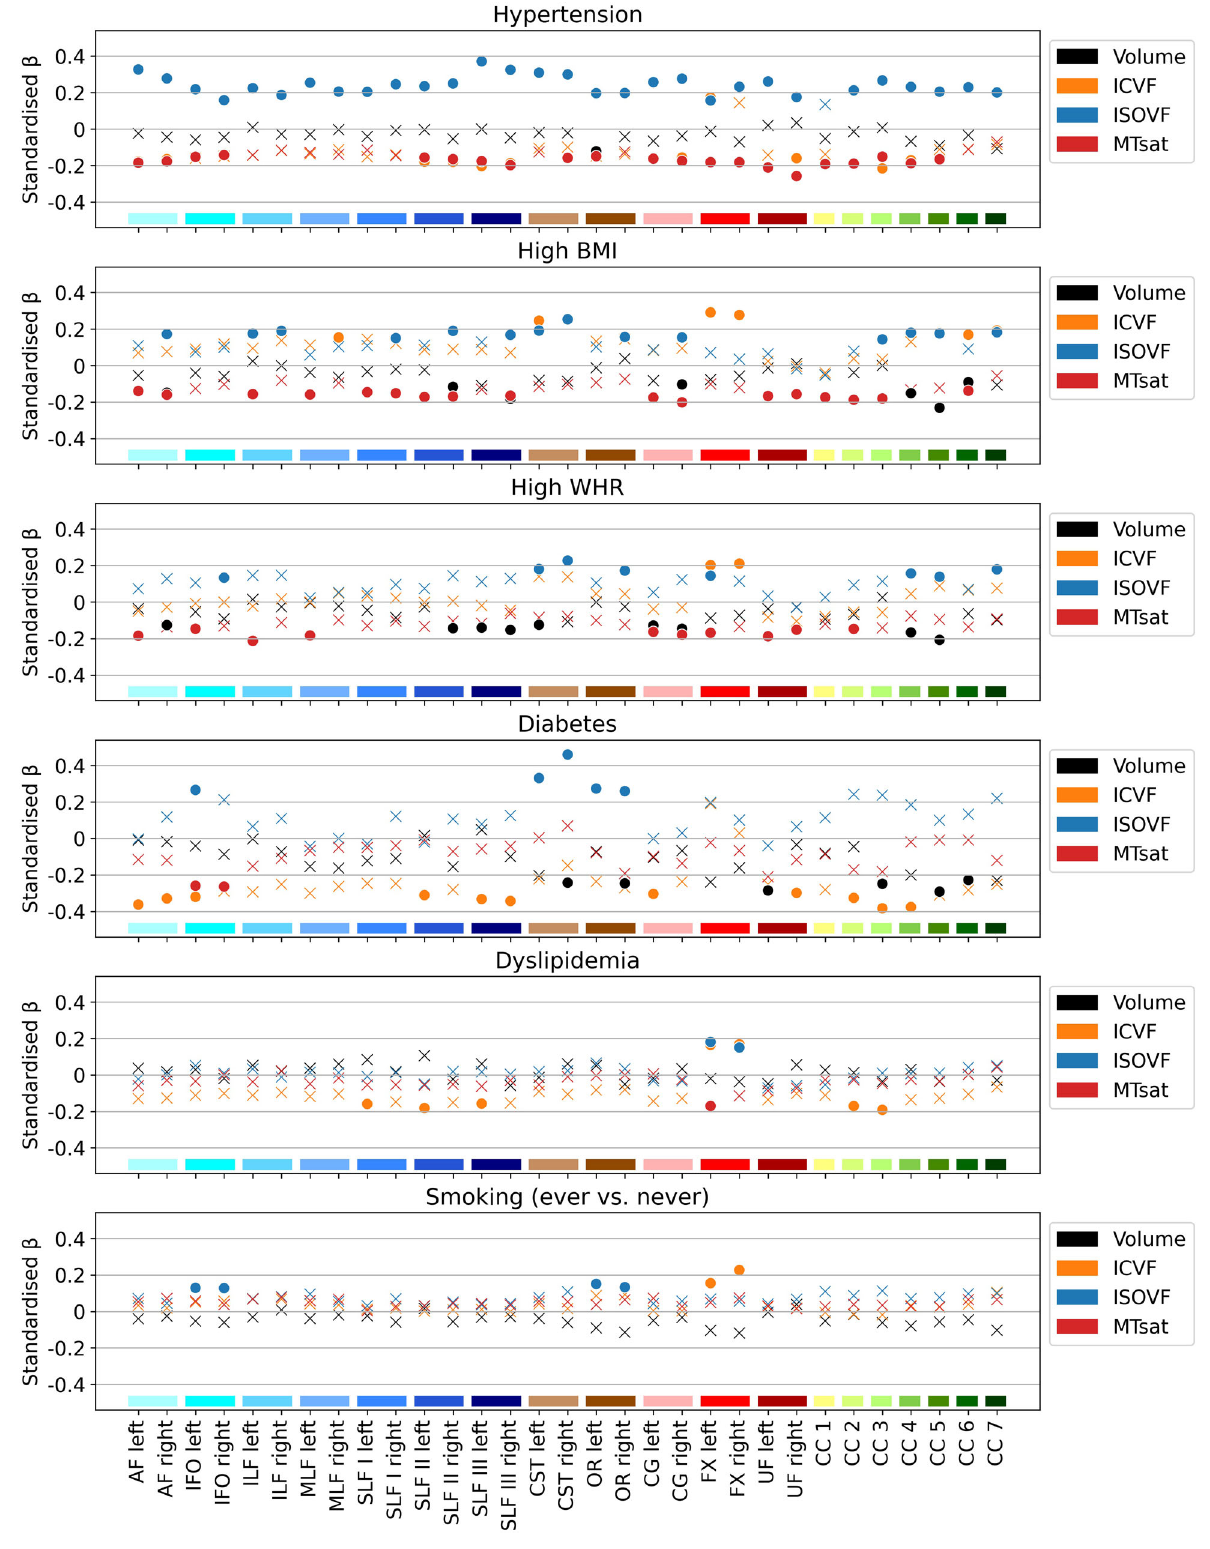
hypertension (Fig. 6b) we observed three patterns: (i) limbic tracts showed lower myelin in the seed structures but not targets, suggesting an anterior-posterior gradient of demyelination; (ii) fronto-parietal (SLF II and III), left fronto-occipital (IFOF) and projection tracts showed a generalised myelin decrease (i.e. in seed, tract and target); and (iii) parietal and occipital GM